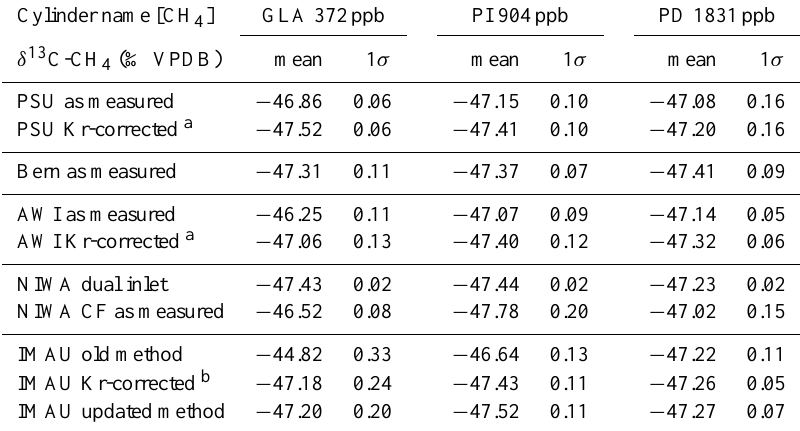
Table 2. Collection of δ 13 C-CH 4 results from the interlaboratory calibration round robin. As described in Sect. 2.5 these three cylinders with contrasting CH 4 mixing ratios are referred as GLA, PI, and PD. For some results Kr correction was applied using the following methods: a using the approach described in Sect. 5.4, and b according to Sect. 5.6. Besides the NIWA (National Institute of Water & Atmospheric Research) lab, which measured the cylinders with dual-inlet IRMS measurement and CF-IRMS, all results were obtained using CF-IRMS. The NIWA dual-inlet data were measured according to Lowe et al. (1999), and Kr would have been pumped away once CO 2 (from CH 4 ) was recovered from the combustion step. These values should be regarded as close to the true values. The NIWA CF-IRMS data were obtained using the method described in Miller et al. (2002) but used a CP-PoraBOND Q column (50 × 0.32mm × 5µm at 40 ◦ C) instead of the Molecular Sieve 5A column at 80 ◦ C used in the original publication. Ideally, the NIWA dual-inlet results and the values after Kr correction should be the same within their common error. Deviations among the results are the sum of differences due to referencing standards, amount effects, and imperfect Kr